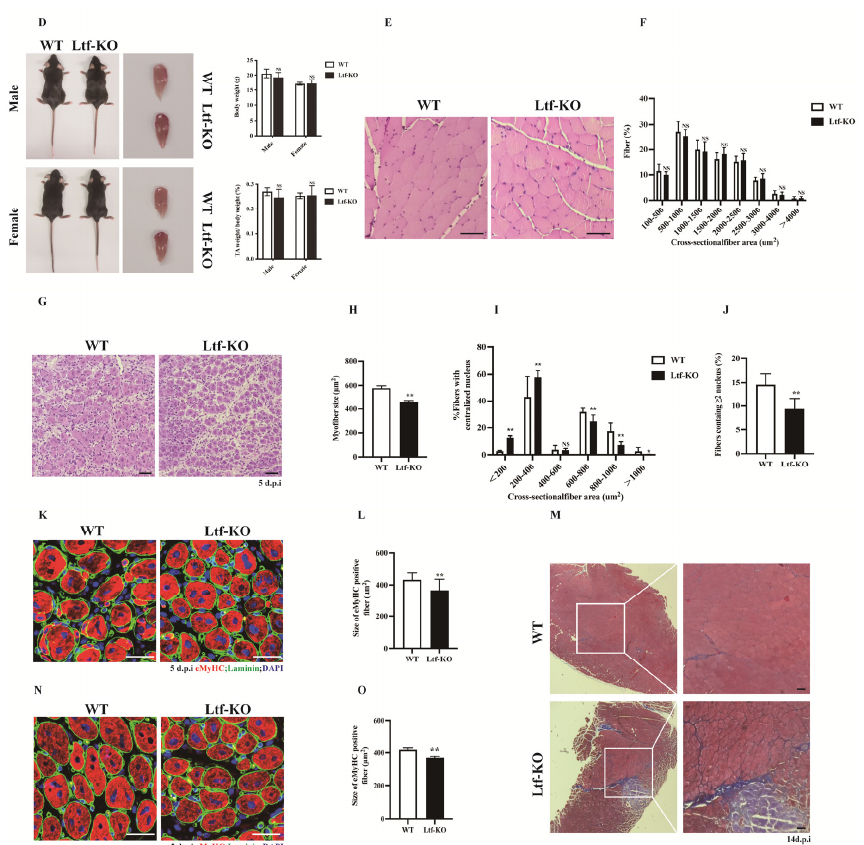
Figure 1. Ltf deficiency impairs regenerative capability of skeletal muscle. ( A ) Real-time RT-PCR of Ltf expression levels in WT mice of TA muscle from days 0 to day 7 after BaCl 2 injury and detected the TA tissue of Ltf -KO mice injured for 1 day and 3 days. ( B ) Immunoblots illustrate the protein levels of Ltf and an unrelated GAPDH in TA muscles from days 0 to day 7 after BaCl 2 injury and detected the TA tissue of Ltf -KO mice injured for 1 day and 3 days. ( C ) Immunofluorescence results represent Ltf expression in WT and Ltf -KO mice of TA tissue on day 1 of injury. Scale bar: 10 µ m. ( D ) Absolute body weight of adult WT and Ltf -KO mice, relative uninjured TA muscle wet weight of adult WT and Ltf -KO mice. ( E ) Pathological analysis plots represent hematoxylin and eosin (H&E) –stained TA cross-sections (CSA) of WT and Ltf -KO mice in the uninjured state. Scale bar: 60 µ m. ( F ) Myofiber size (percentage) distributions of WT and Ltf -KO TA muscle were measured by using ImageJ software. ( G ) Representative photomicrographs of H&E-stained sections showing a delayed regeneration of injured TA muscle in Ltf -KO mice compared with that in WT at day 5 after BaCl 2 injection. Scale bar: 60 µ m. ( H ) Statistical analysis of mean area of TA muscle CSA in adult Ltf -KO and WT mice 5 days after injury. ( I ) Regenerated myofiber size (percentage) distributions of WT and Ltf-KO TA muscle 5 days after BaCl 2 injury were measured by using ImageJ software. Only myofibers with centrally located nuclei were counted. ( J ) Quantification of the ratio of regenerating myofibers containing two or more centralized nuclei per field at day 5 post-injury. ( K ) Representative overlaid photomicrographs of TA muscle sections of WT and Ltf -KO mice 5 days post-injury after immunostaining for eMyHC (red) and laminin (green). Nuclei were labeled by DAPI. Scale bar: 30 µ m. ( L ) Average CSA of eMyHC-positive fibers in TA muscle 5 days post-injury. ( M ) Representative photomicrographs of Masson-stained sections show increased collagen fibers in damaged TA muscles in Ltf -KO mice compared to WT at day 14 after BaCl 2 injection. Scale bar: 60 µ m. ( N ) At 60 days after the first injury, a second injection of BaCl 2 solution was delivered to the muscle of WT and Ltf -KO mice, and the muscle was analyzed at day 5 after the second injury. Scale bar: 30 µ m. ( O ) Average CSA of eMyHC-positive fibers in TA muscle at 5 days after the second injury. n = 3 in each group. * p < 0.05; ** p < 0.01; NS, not